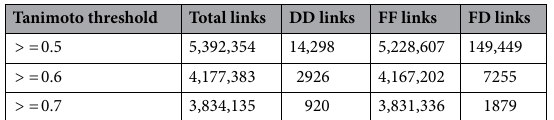
Table 1. Number of links in the graph after applying different Tanimoto similarity